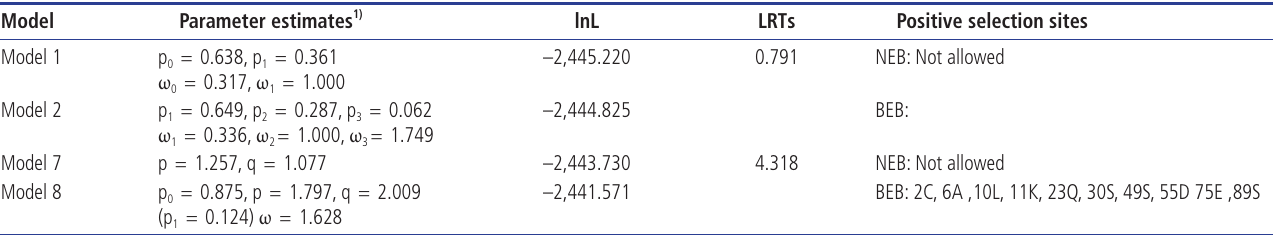
Table 2. Results of positive selection tests for interleukin-32 gene Model